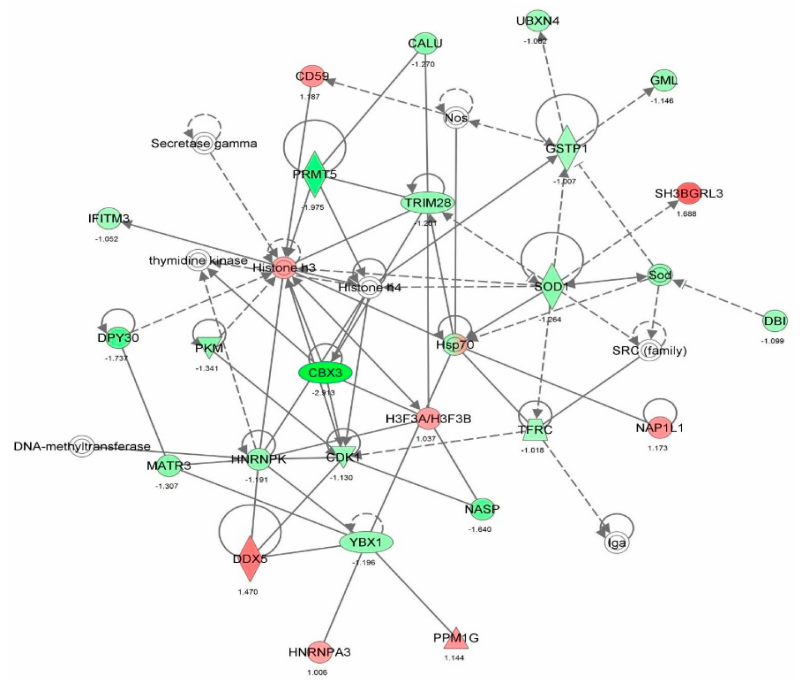
Figure 10. Vancomycin regulated cellular growth and proliferation, infectious disease, and cellular development. Red indicates an up-regulation; green indicates a down-regulation. The intensity of green and red colors indicates the degree of down- or up-regulation. Solid arrow indicates direct interaction and dashed arrow indicates indirect interaction.